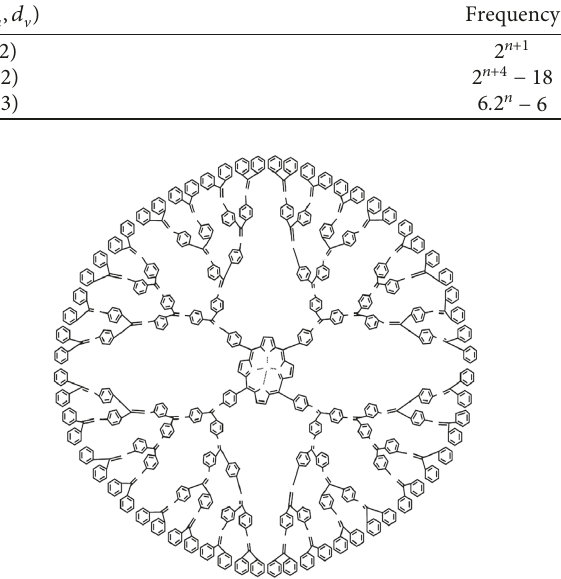
n . n , of end vertices of